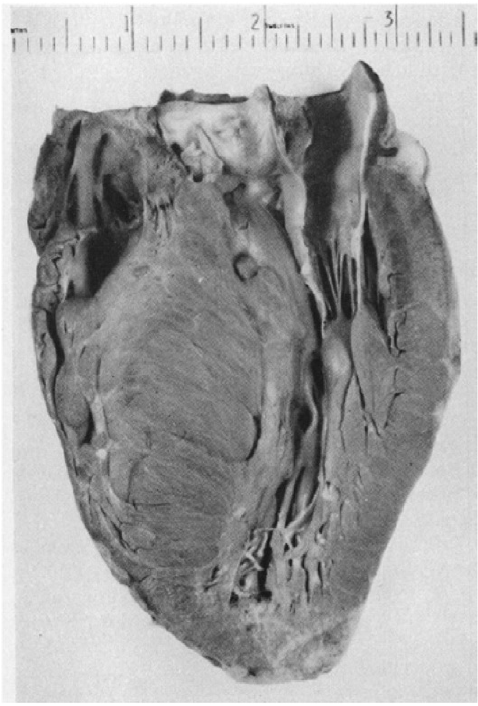
Figure 1. Gross anatomy of the heart in a patient with familial HCM (Ref.